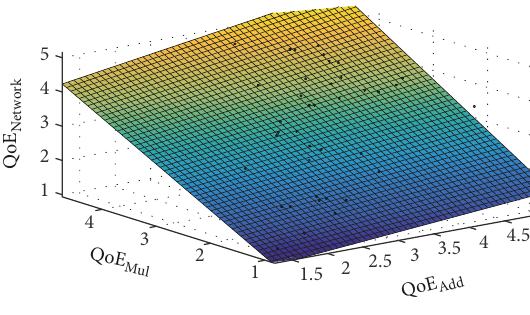
Table 14: Normalized matrix for weight calculation.